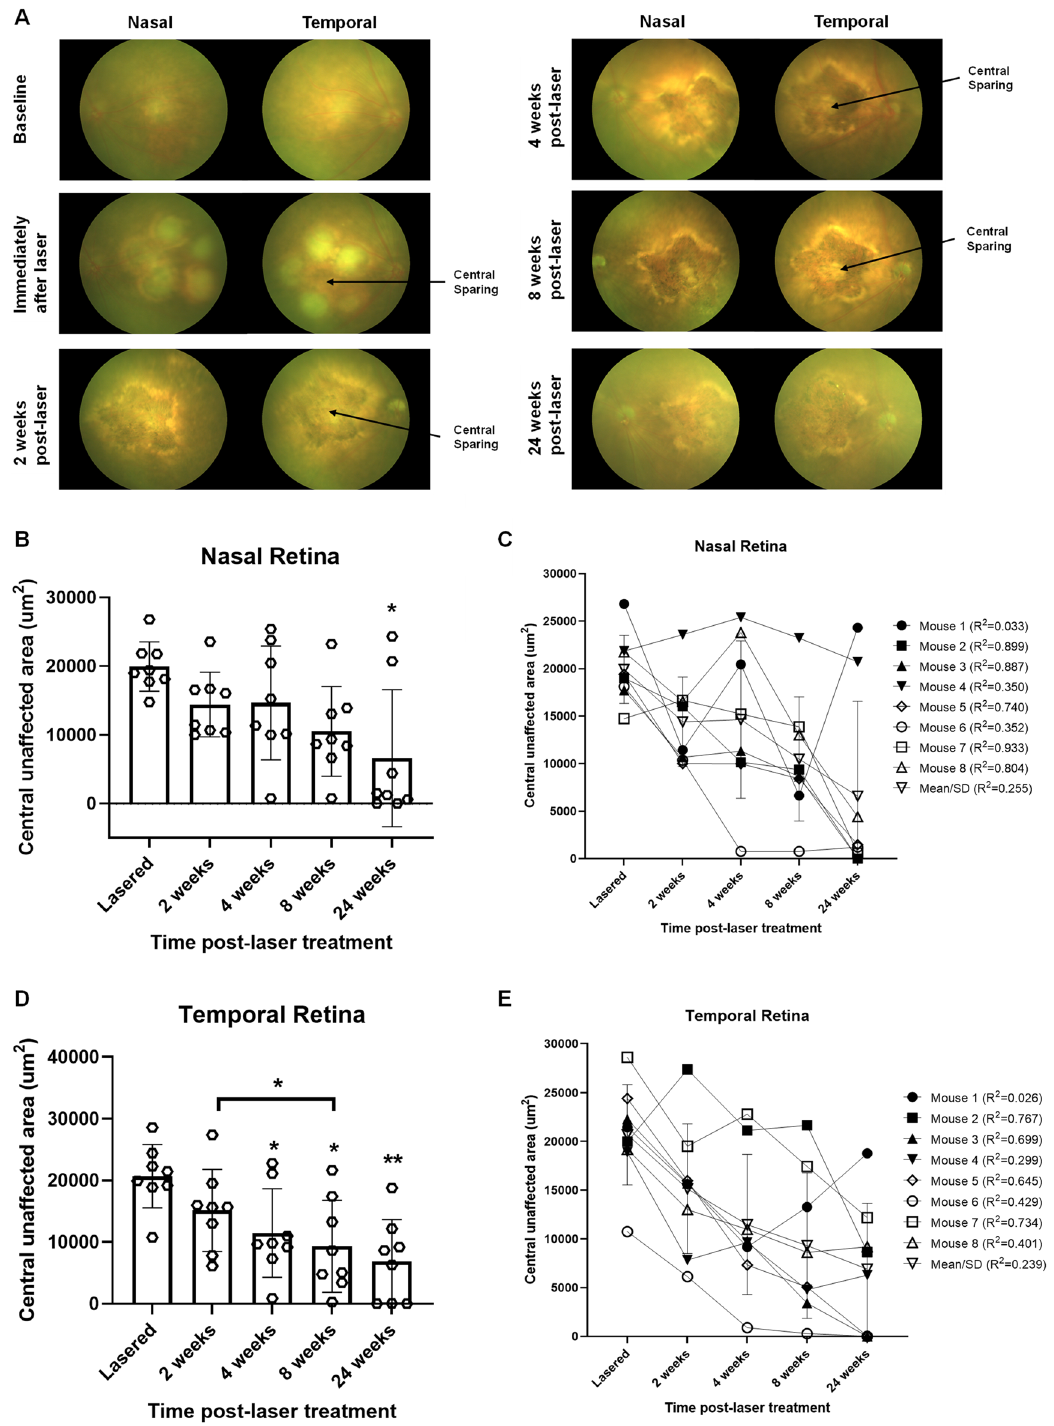
Figure 1. Laser-induced retinal lesions with central sparing (RLCS) progress to form GA-like atrophy with gradual reduction in area of the central untreated retina. ( A ) Representative colour fundus photographs are shown, taken at baseline (before laser treatment), immediately after laser treatment, and 2-, 4-, 8- and 24-weeks post laser treatment of C57BL/6 J female mice. Laser treatment consisted of creating a retinal lesion with 5 laser spots, applied circumferentially to encircle an area of central sparing. One eye of each mouse had a RLCS induced both nasal and temporal to the optic disc. Visible areas of central sparing in the lesions temporal to the optic disc are indicated with an arrow. The data shown in the graphs represent the central mean surface area that remained unaffected in the ( B , C ) nasal and ( D , E ) temporal RLCS at the indicated time points. Data are expressed as ( B ) and ( D ) mean ± SD (n = 8 eyes per group from 8 different mice) and comparison of the indicated time points made to the time of laser using one-way ANOVA testing and Bonferroni post-hoc testing; * p < 0.05, ** p < 0.01. Data are also expressed ( C and E ) to demonstrate the dynamics of the central unaffected area in the individually treated eyes from the 8 different mice over the 24-weeks period, in addition to the mean ± SD of the group of eyes. A linear regression test was carried out for the individually treated eyes, with the R 2 value shown for each mouse and for the group, to determine the relationship between central unaffected area and time